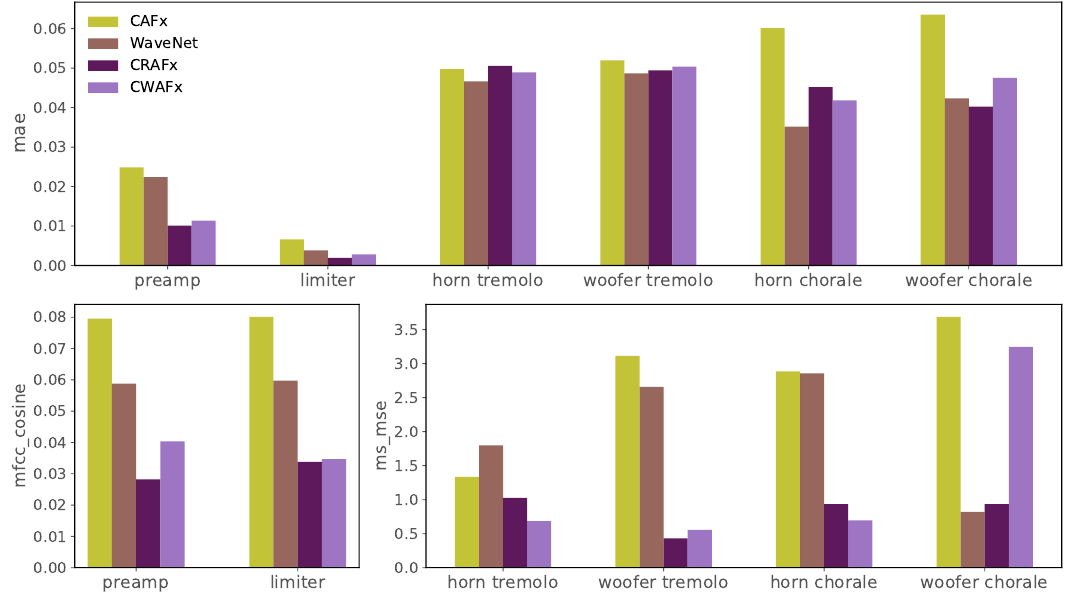
Figure 5. mae , mfcc_cosine and ms_mse values with the test dataset for all the modeling tasks. In terms of perceptually-based metrics such as the mfcc_cosine and ms_mse , the CRAFx and CWAFx models achieved the best scores. This with the exception of the woofer chorale task, where the CWAFx model did not manage to accomplish the task. Overall, CRAFx and CAFx correspond to the highest and lowest scoring models,